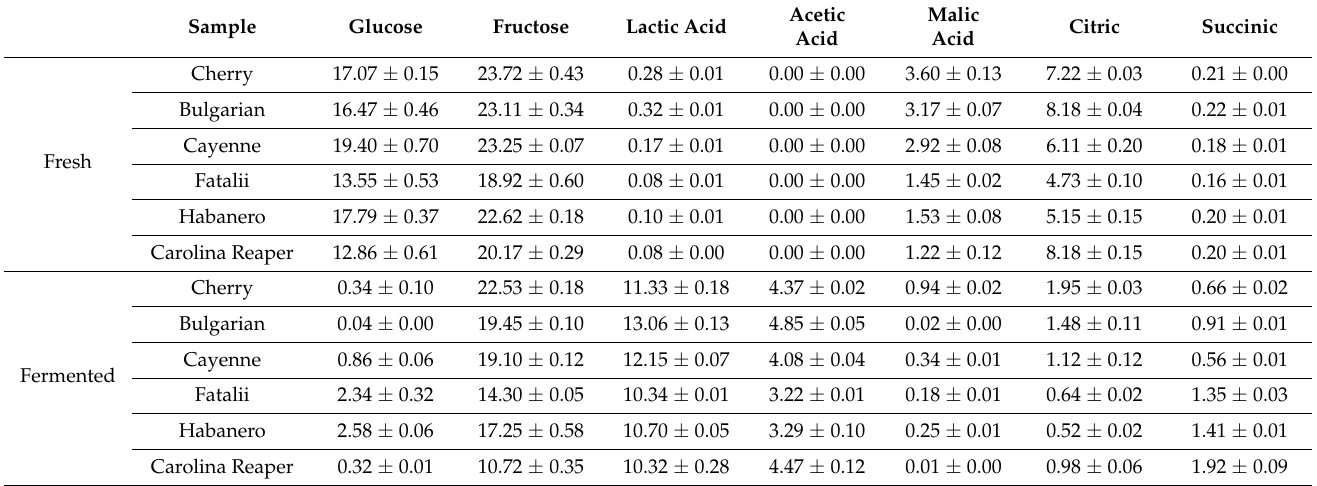
Table 7. Evaluation of sugar and acid content of different pepper samples